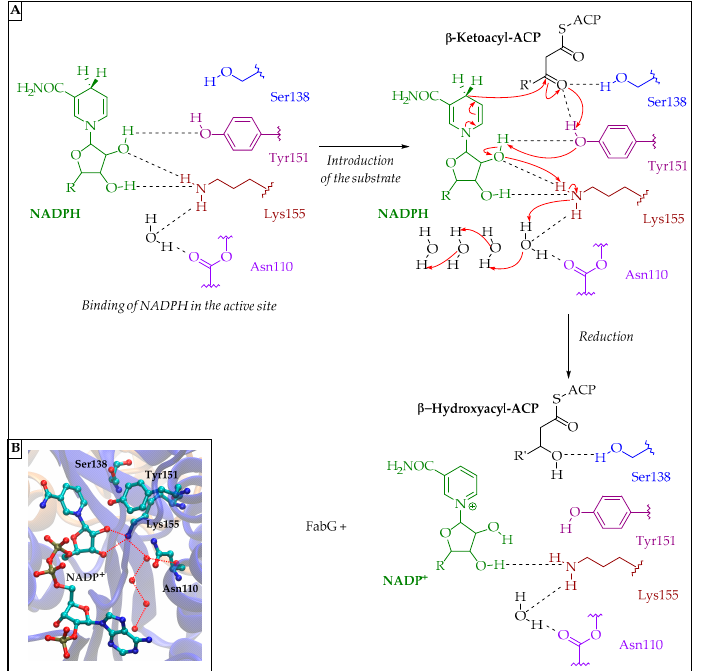
Figure 18. ( A ) Scheme of the mechanism of the reduction catalysed by Ec FabG. ( B ) View of the active site of Ec FabG-NADP + structure (PDB ID 1Q7B) highlights the hydrogen bonds between the hydroxy groups of NADP + and Lys155 as well as the proton relay system (red dots) involving Lys155, Asn110 and four water molecules shown as red spheres.